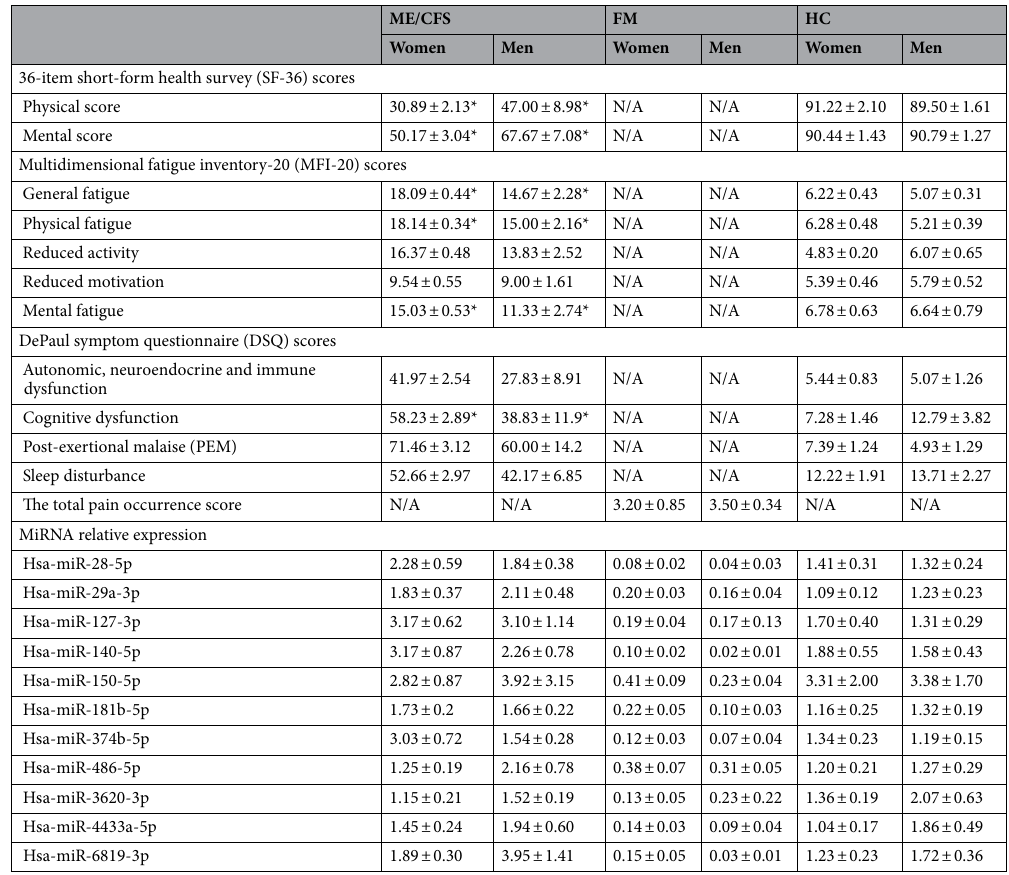
Table 2. Impact of biological sex on symptom severity and miRNA expression. The health self-reported questionnaires scores for different categories of SF-36, MFI-20, DSQ questionnaires, the total pain occurrence score and the relative expression of the 11 miRNAs of interest. All data are presented as mean and ± standard error of the mean. One-way ANOVA followed by Tukey’s multiple comparisons test were performed to determine the level of the significant difference between the men and women in different groups. Results were considered significant at * P -value < 0.05, ** P -value < 0.01, *** P -value < 0.001, **** P -value <